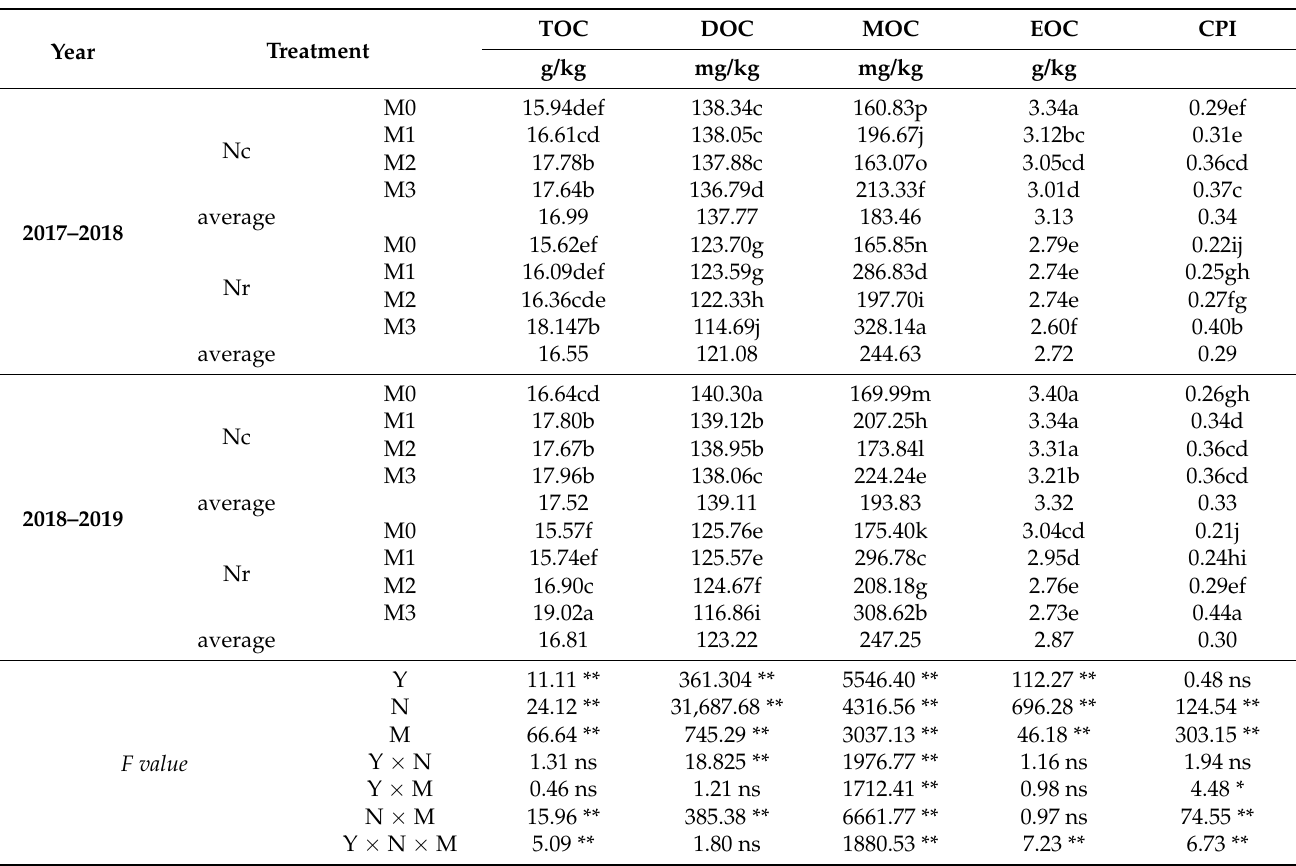
Table 2. Effects of different nitrogen treatments on soil carbon pool components in paddy fields.